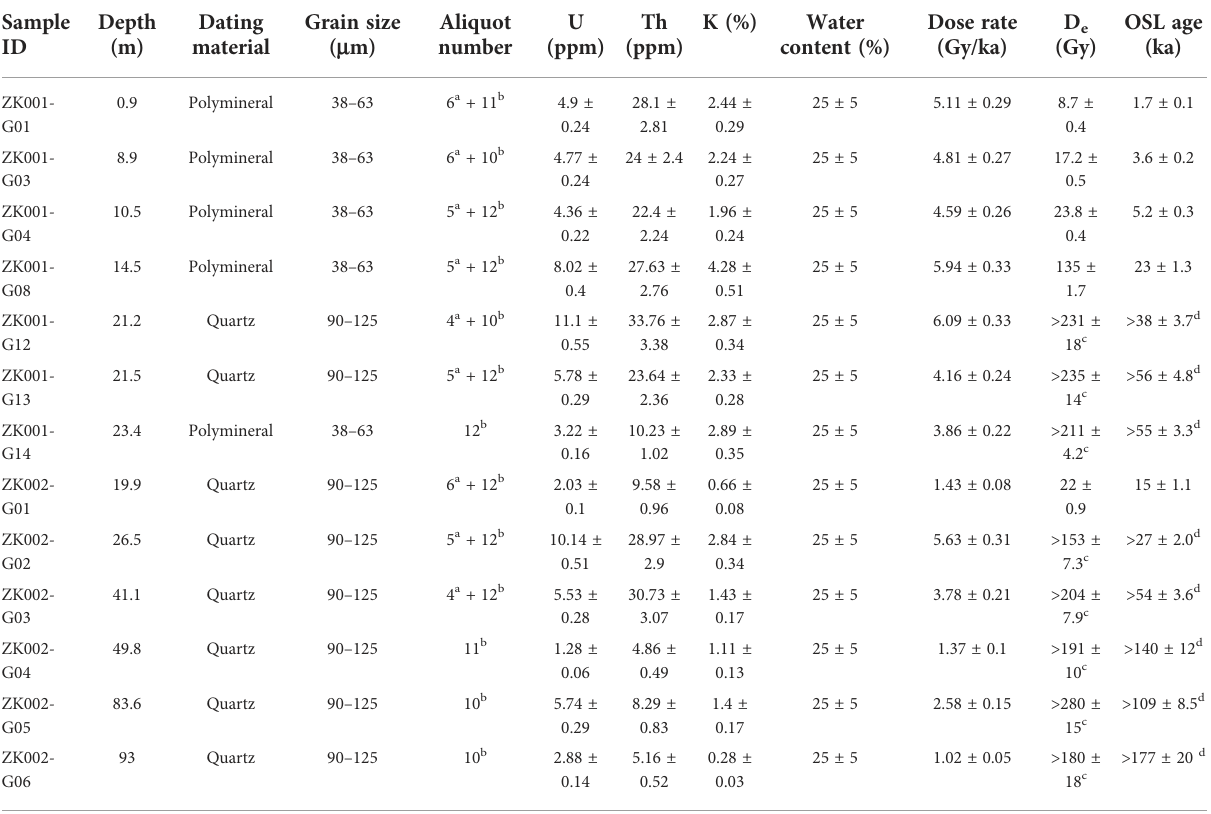
TABLE 2 OSL dating results for samples from cores ZK001 and ZK002, the Chaoshan plain.